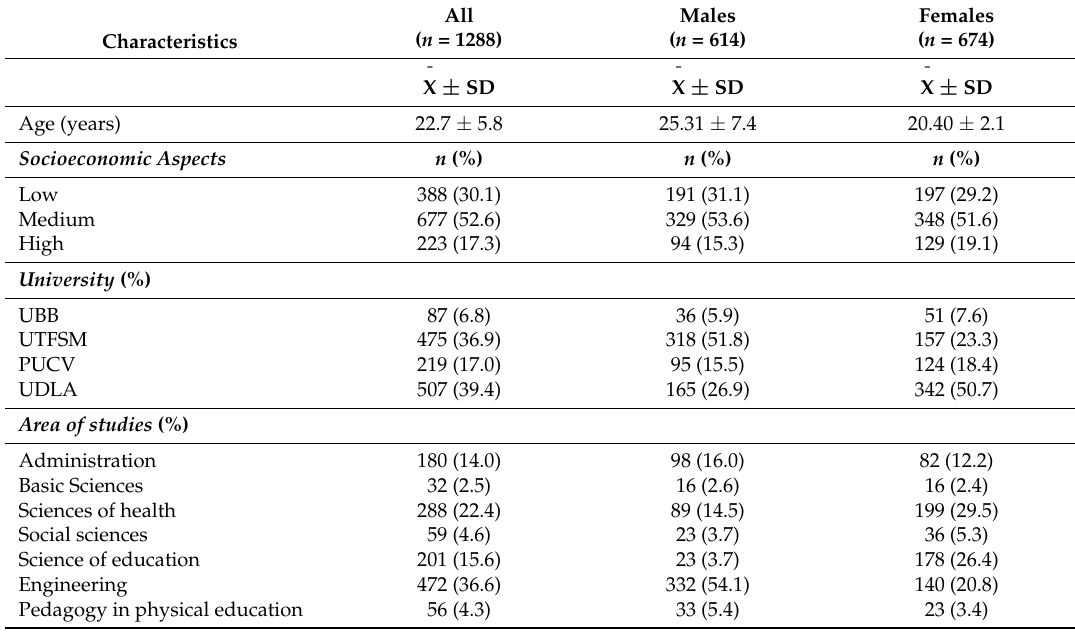
Table 1. General characteristics of participants (average and standard deviation/frequency) and differences between male and female students.